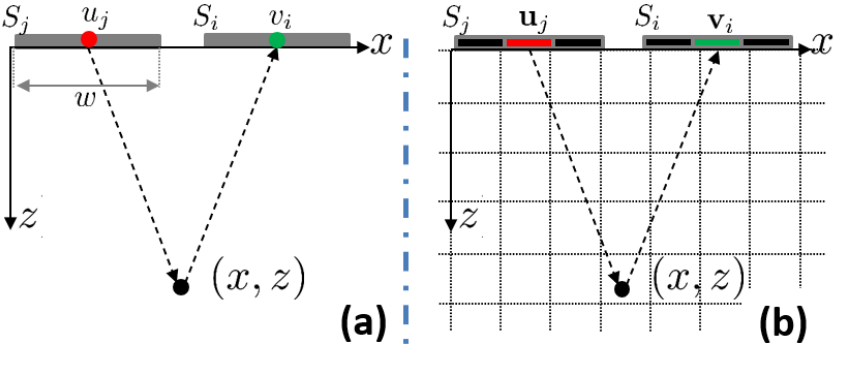
Figure 2. ( a ) Schematic representation of the ultrasound wave emitter j , receiver i , and the associated coordinate system. ( b ) Proposed discretization for the transducers and propagation medium Ω . The surfaces S j and S i are divided into N